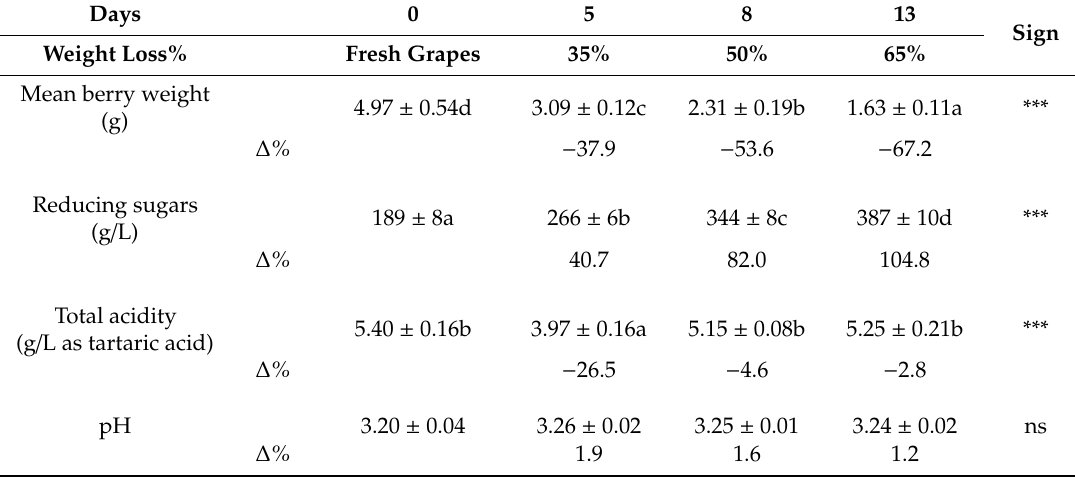
Table 1. Evolution of Muscat Alexandria grapes composition during